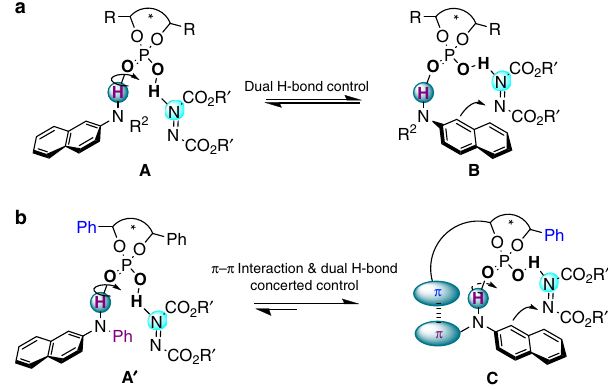
Fig. 2 Reaction strategy. a Initial dual hydrogen-bonding strategy. b Modi fi ed strategy: concerted control of π - π interaction and dual H-bond strategy